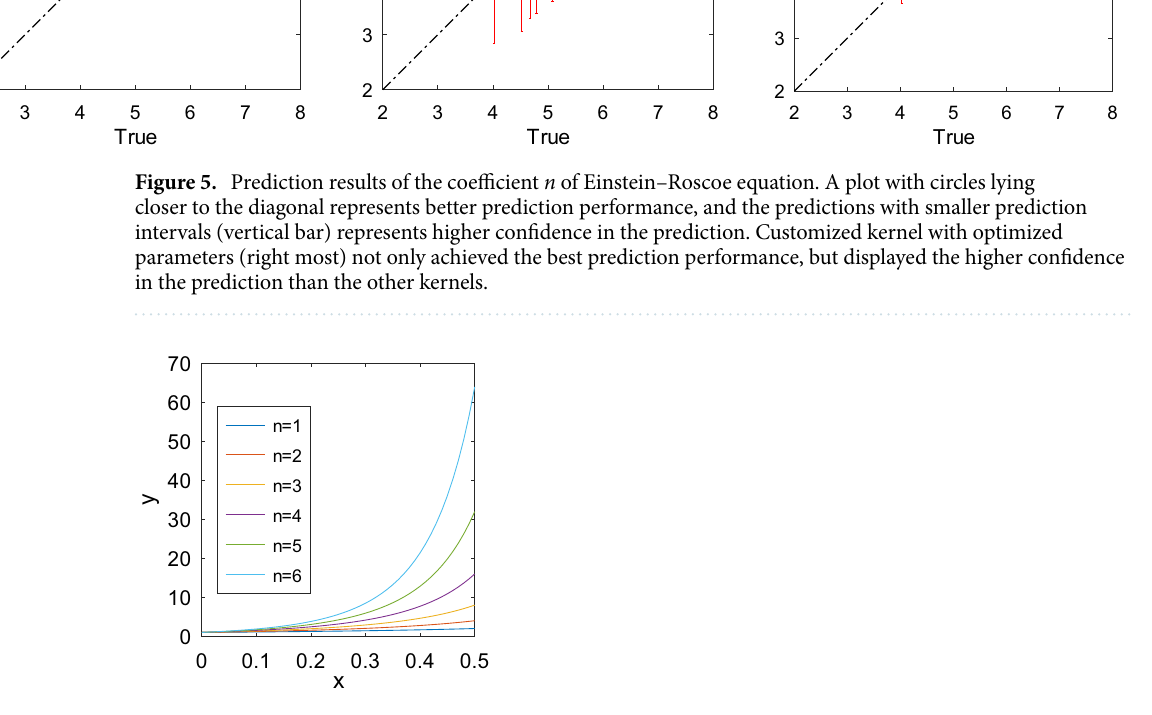
Figure 6. Einstein–Roscoe equation for a = 1 , and various n